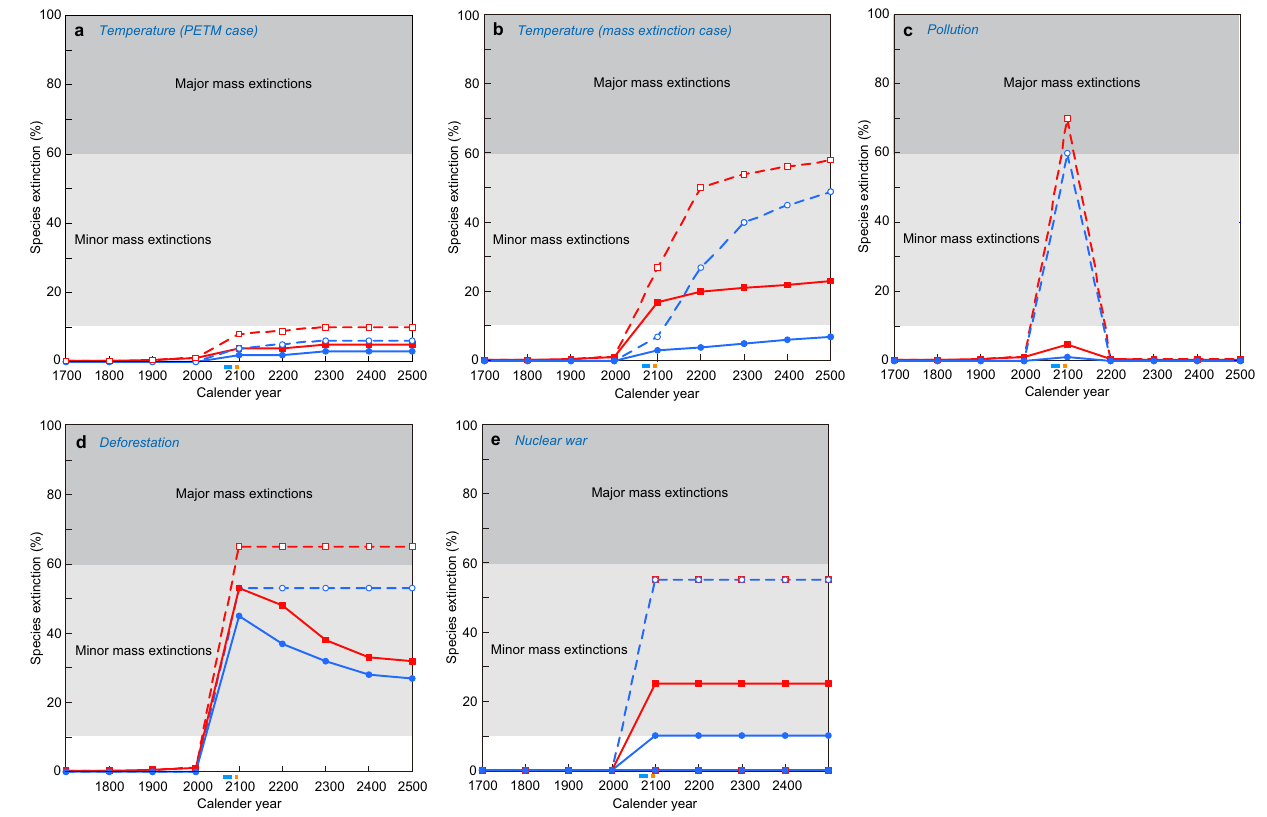
Figure 3. Animal species extinction percentages in the marine (blue) and terrestrial (red) realms from CE 1700 to 2500 resulting from global surface temperature changes in the PETM case ( a ), those in the mass extinction case ( b ), pollution ( c ), deforestation ( d ), and stratospheric soot introduced by nuclear war ( e ) in the most likely case (solid line) and the worst case (dushed line). This figure is made from data in Figs. 1 and 2. The light blue and orange bars under the horizontal axes show the timing of the stoppage of GHG emissions in the most likely case and in the worst case, respectively. These data are shown in Supplementary Tables S3 and